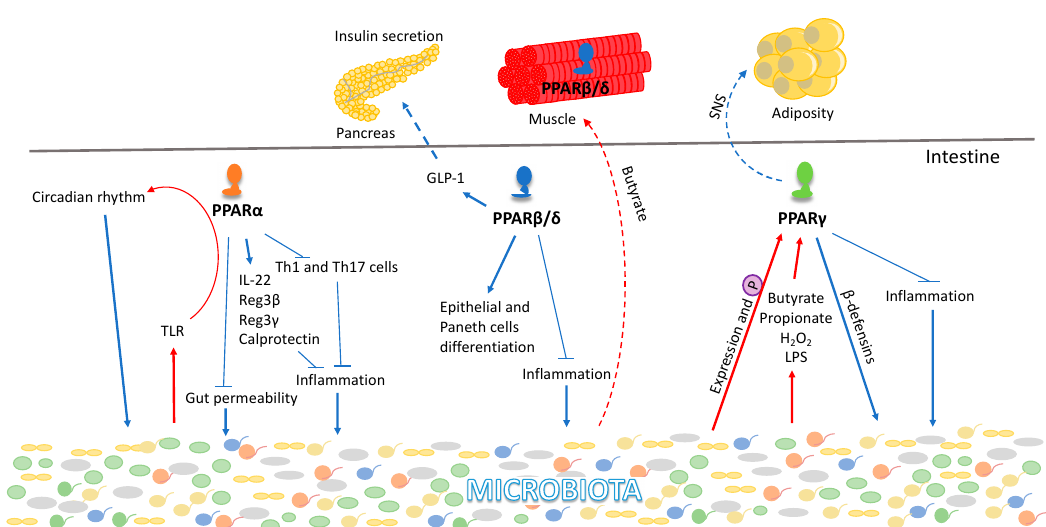
Figure 3. Roles of PPARs in the gastrointestinal tract. All three PPAR isotypes act in the intestine to reduce inflammation, whereby they modulate the microbiota composition. PPAR α functionally interacts with gut bacteria and mediates their signals to regulate the circadian rhythm. Intestinal PPAR β / δ plays an important role in the development of the intestine, whereas in muscle it is activated by bacterial metabolites, such as short-chain fatty acids like butyrate. Besides its key role of extinguishing inflammation and its dialog with gut bacteria, PPAR γ also mediates information concerning nutrient status from the gut to the adipose tissue. Circled P indicates phosphorylation. Red and blue arrows indicate microbiota and host effects, respectively. Solid lines represent the reciprocal interactions of PPARs in the intestines and microbiota. Dotted lines show the distant effects of intestinal PPARs and organ-organ crosstalk on various metabolic organs such as pancreas, muscle and white adipose tissue. TLR: toll-like receptors; LPS: lipopolysaccharides; SNS: sympathetic nervous system; Reg3: regenerating islet-derived 3; GLP-1: glucagon-like peptide-1; Th1, 17 cells: T-helper type 1, 17 cells; IL-22: interleukin-22.